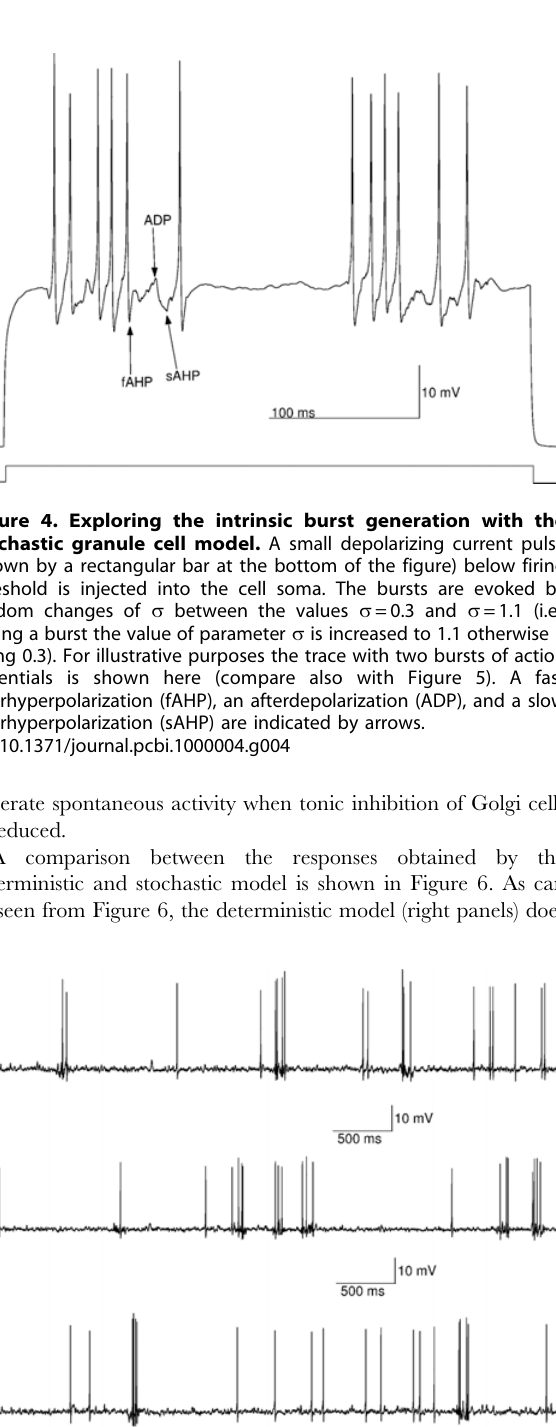
Figure 6. Comparison between the responses obtained by the deterministic and stochastic models. The length of each trace is 0.4 seconds. In A) the depolarizing current is below firing threshold ( I app =11 pA) and in B) just above firing threshold ( I app =12 pA). In C), the depolarizing current is considerably larger ( I app = 29 pA). The deterministic model (right panels) does not reproduce the experimen- tally observed irregularity in firing. The responses simulated by the stochastic model (left panels), on the contrary, very closely resemble the experimentally obtained irregularities (for more details, see the Electroresponsiveness Obtained by the Stochastic Model Only section). For the stochastic traces s =0.5. For each value of the depolarizing current, I app , traces from three independent simulations of the stochastic model are shown to illustrate the variability of firing.